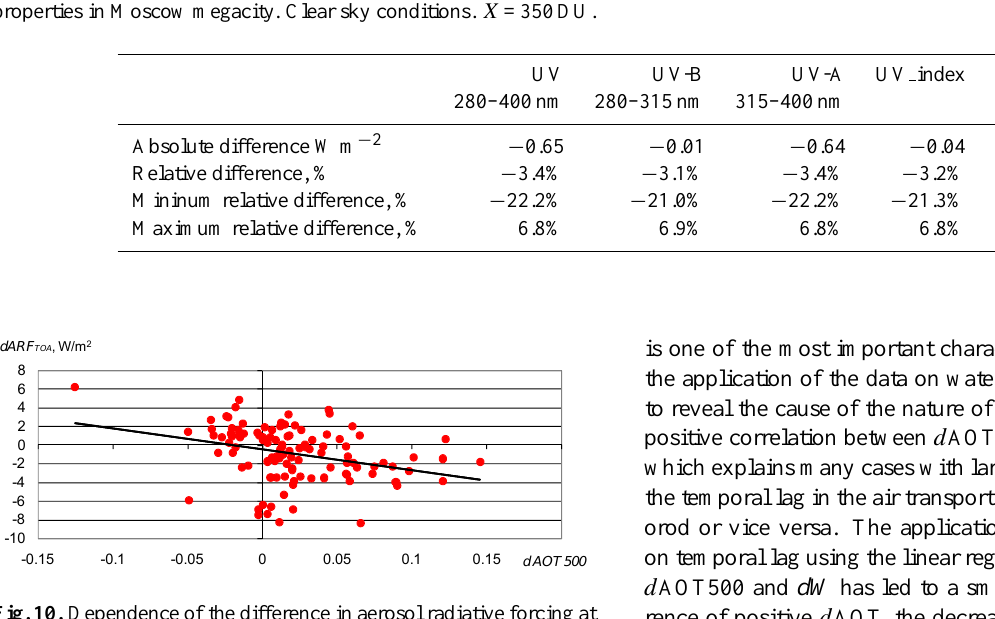
Table 3. Absolute and relative differences in ultraviolet and visible (PAR) irradiance reaching the surface due to the changes in aerosol properties in Moscow megacity. Clear sky conditions. X =350DU.